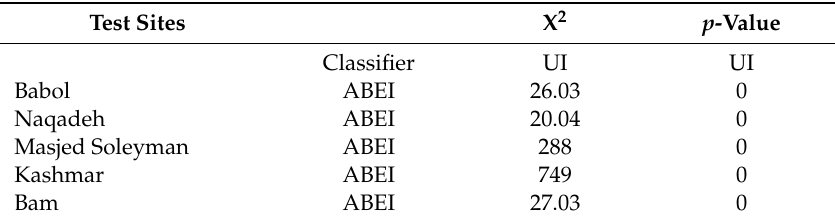
Table 4. McNemar chi-square test results for the five test Table 3. Summary of the classification accuracies of the various methods by test site.